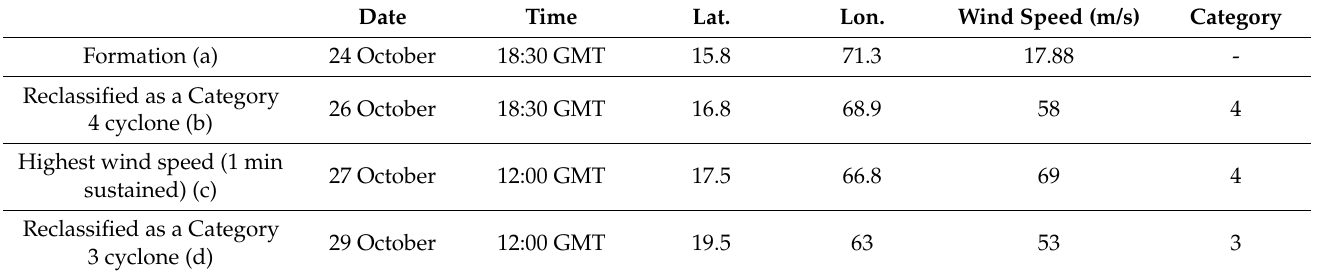
Figure 4. Tropical cyclone Kyarr wind field (based on ECMWF data) over the Arabian Sea at different times mentioned in Table 1; a darker gray color indicates a higher wind speed. (X and Y axis show the longitude and latitude, respectively). ( a ) 24 October, ( b ) 26 October, ( c ) 27 October and ( d ) 29 October. Table 1. Track statistics related to four timesteps of tropical cyclone Kyarr illustrated in Figure